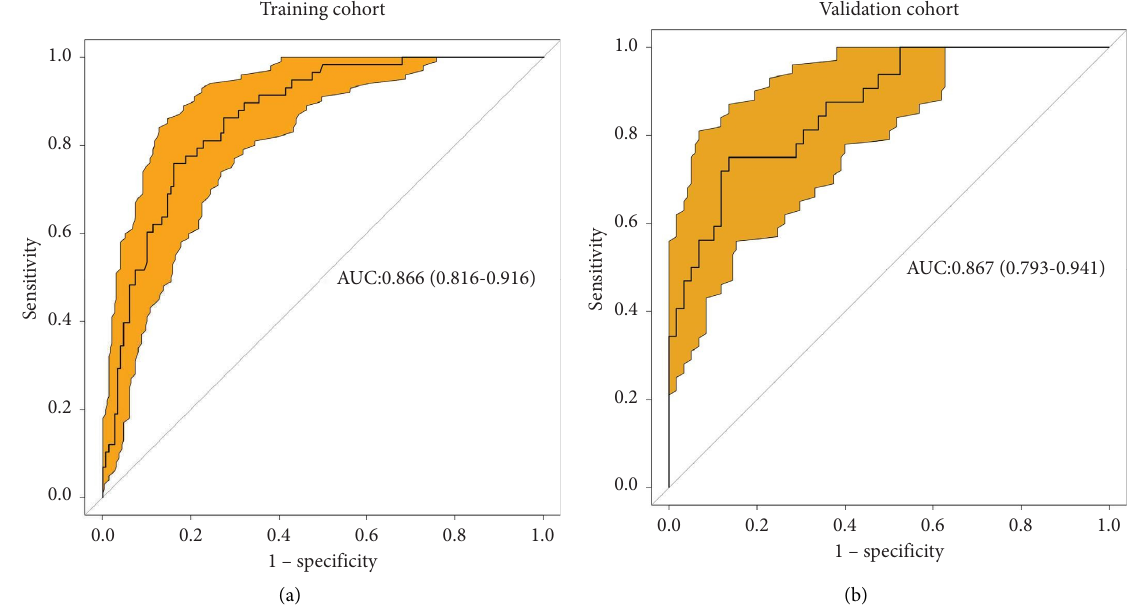
Figure 2: Receiver operating characteristics (ROC) of the nomogram in the training cohort (a) and validation cohort (b).